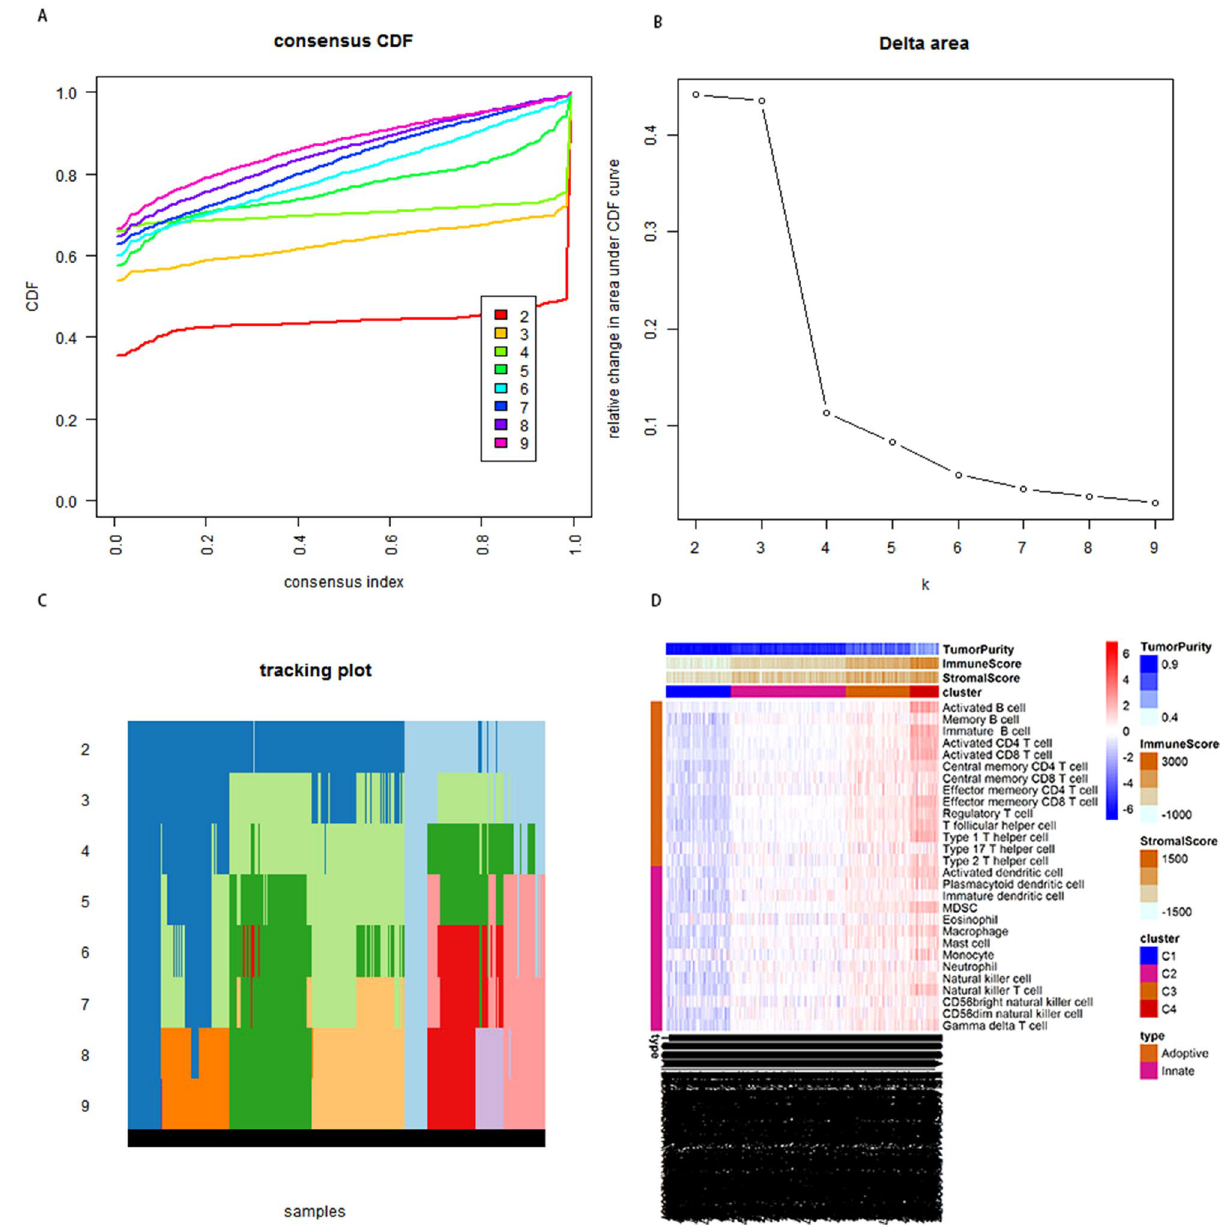
Figure 3. The consistent cluster map of immune cells. CDF (cumulative distribution function) showed that a k value of 4 was the optimal number for the subgroups ( B ). In addition, a heat map was drawn to show differences in tumor purity, immune and stromal scores among the different subtypes ( D (hsa04927), as shown in Fig. 7E–H. Furthermore, the STRING online tool was used to construct a Protein–pro- tein Interaction (PPI) network of the differentially expressed genes related to cold and hot tumors. Notably, the up-regulated differential genes with a node connection greater than 20 were considered to be hub genes. On the other hand, the down-regulated differential genes with a node connection greater than 10 were defined as hub genes (Fig. 7I: the protein interaction network of the down-regulated differential genes; Fig. 7J: the pro- tein interaction network of the up-regulated differential genes). The analysis revealed 19 up-regulated and nine down-regulated hub genes. Moreover, the protein interaction network revealed a wide range of links between the markers related to the stromal scores and the markers related to immune scores in the differentially expressed genes, which may be related to the higher immune and stromal scores in hot tumors. The tumor‑related regulatory molecules and enrichment analysis of tumor‑related mole‑ cules. T cell-based cancer immunotherapy, including checkpoint suppression or adoptive cell therapy, has greatly revolutionized cancer treatment 37 . It is also well known that immunity plays a significant role in the